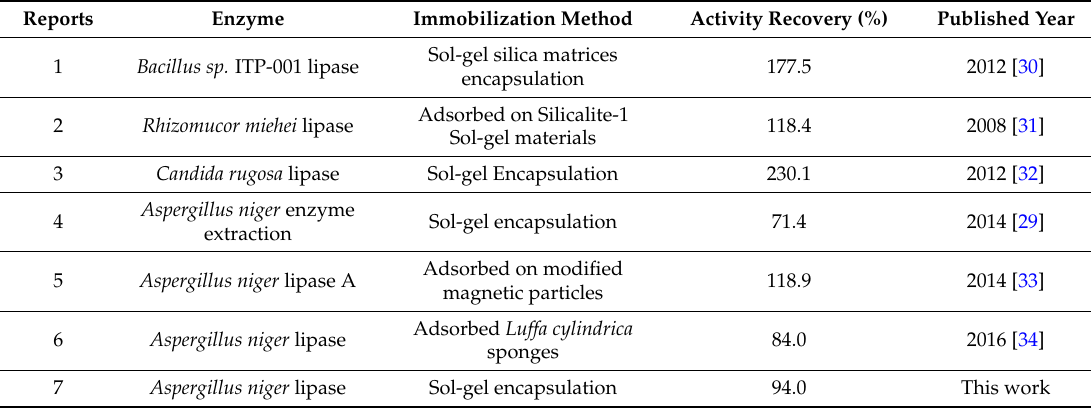
Table 4. A comparison of immobilization results with other related reports.